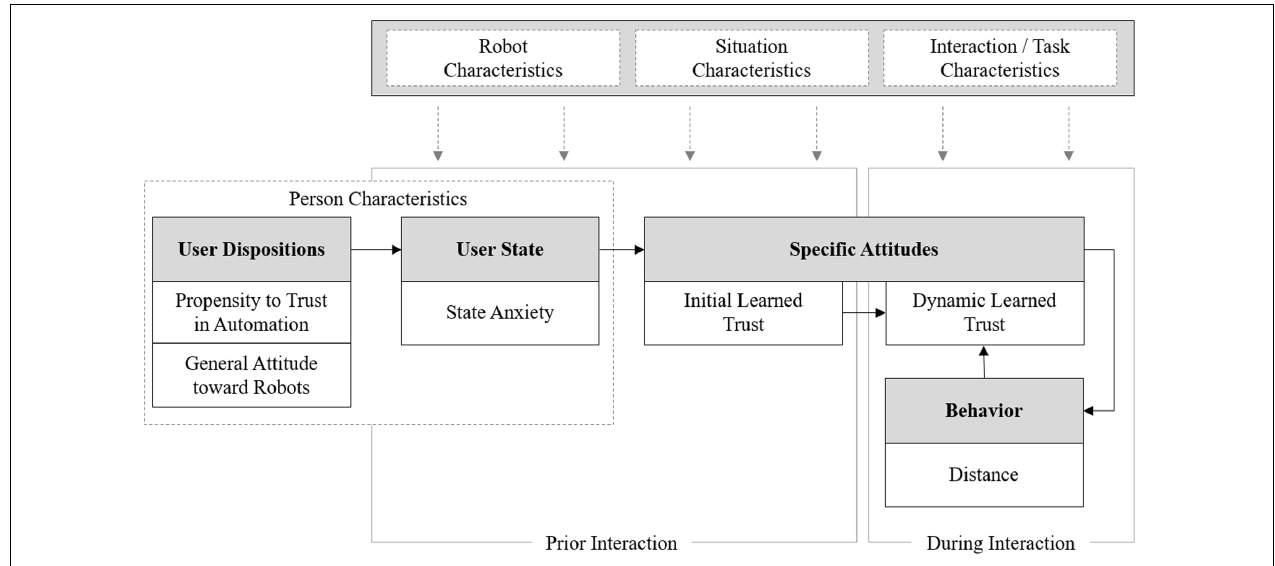
FIGURE 1 | Study framework based on the Three Stages of Trust (Kraus,